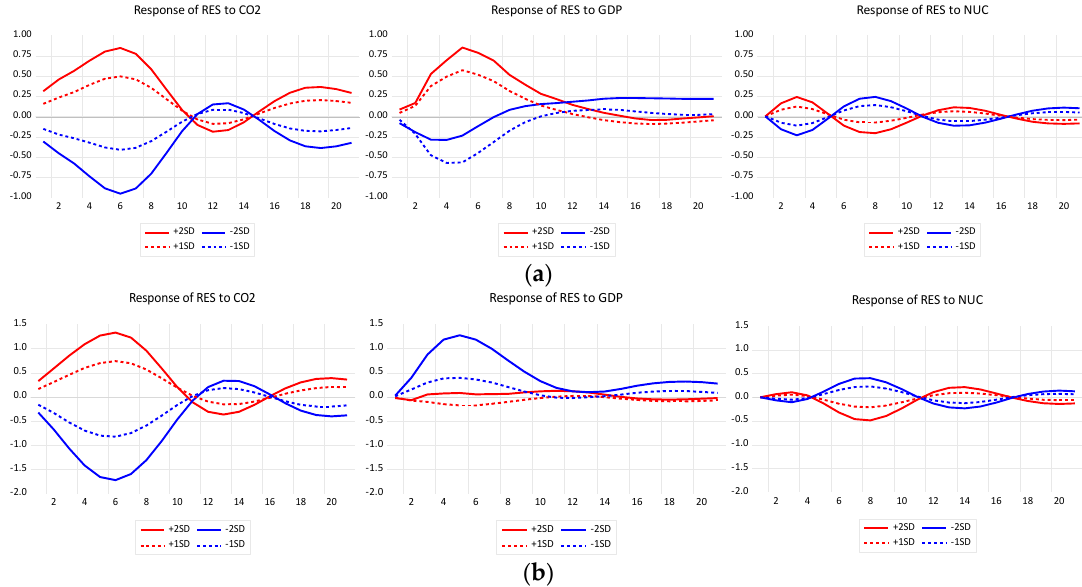
Figure 6. Responses of renewable energy consumption to shocks in CO 2 emissions, GDP and nuclear energy consumption in ( a ) upper regime; ( b ) lower regime.